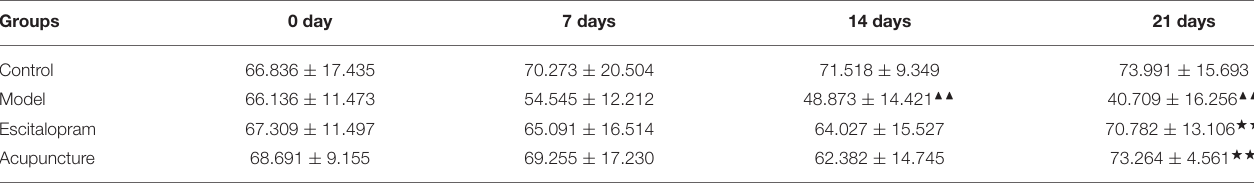
TABLE 2 | Effects of acupuncture on the changes of sucrose preference rate of CRS rats.